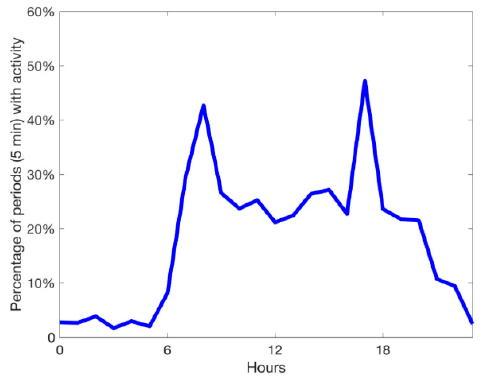
Figure 4. Percentage of five-minute periods with a positive physical activity index of all patients for 24 h.